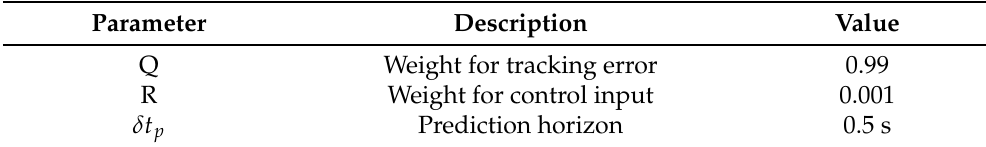
Table 1. Design parameters of AMPC for longitudinal